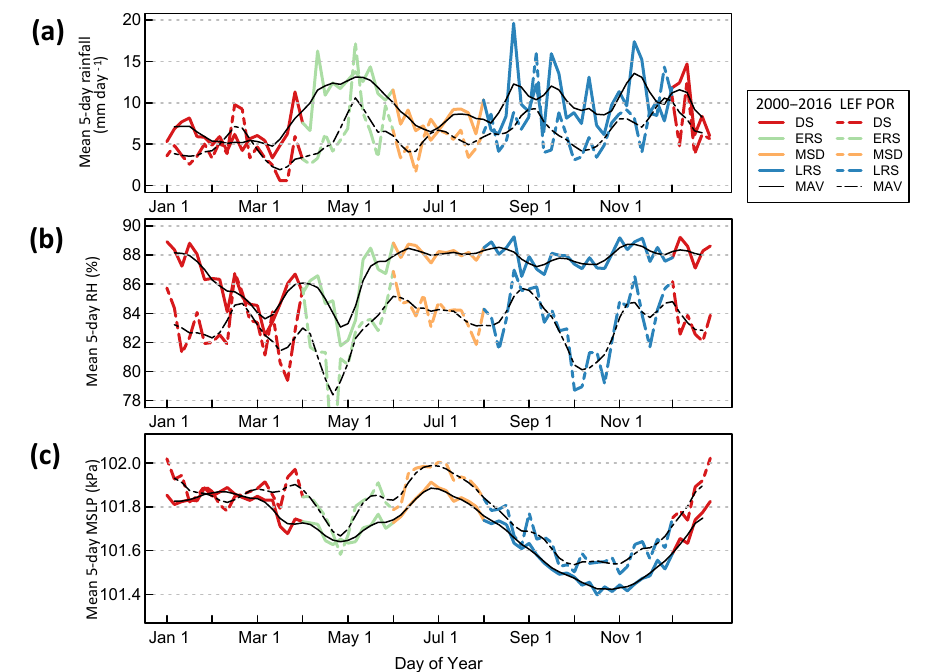
Figure 1. Day of year mean values for (a) precipitation at 361m, (b) relative humidity (RH) at 361m, and (c) mean sea level pressure (MSLP) at 100m in the Luquillo Experimental Forest (LEF) sites. The colors show the 5-day means during the winter dry season (DS), early rain season (ERS), midsummer dry season (MSD), and late rain season (LRS). The black line is the 15-day moving average (MAV), with the 2000–2016 period as solid lines and the LEF ceilometer period of record (LEF POR) of May 2013 through August 2016 as dashed lines.